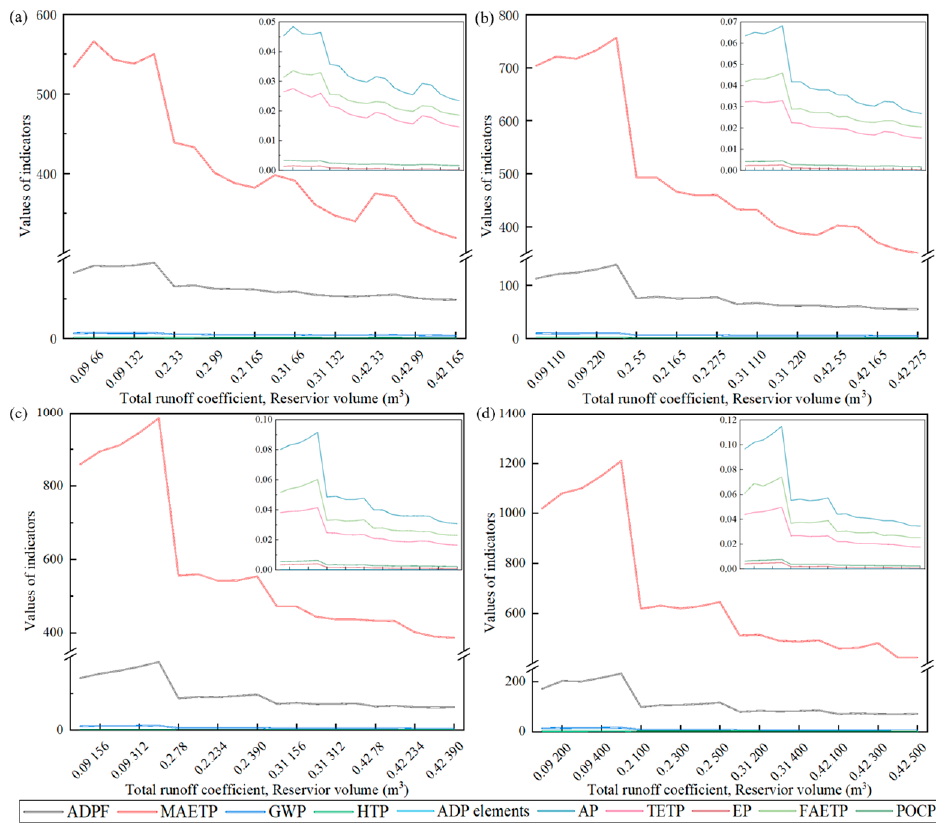
Figure 4. Life cycle assessment results of community-based rainwater utilization when the floor area ratio was: ( a ) 1; ( b ) 1.7; ( c ) 2.4; ( d ) 3.1. (EP: eutrophication potential; FAETP: freshwater aquatic ecotoxicity potential; POCP: photochemical ozone creation potential; ADP elements: abiotic depletion potential elements; AP: acidification potential; TETP: terrestrial ecotoxicity potential: global warming potential; HTP: human toxicity potential; ADPF: abiotic depletion potential for fossil fuels; MAETP: marine aquatic ecotoxicity